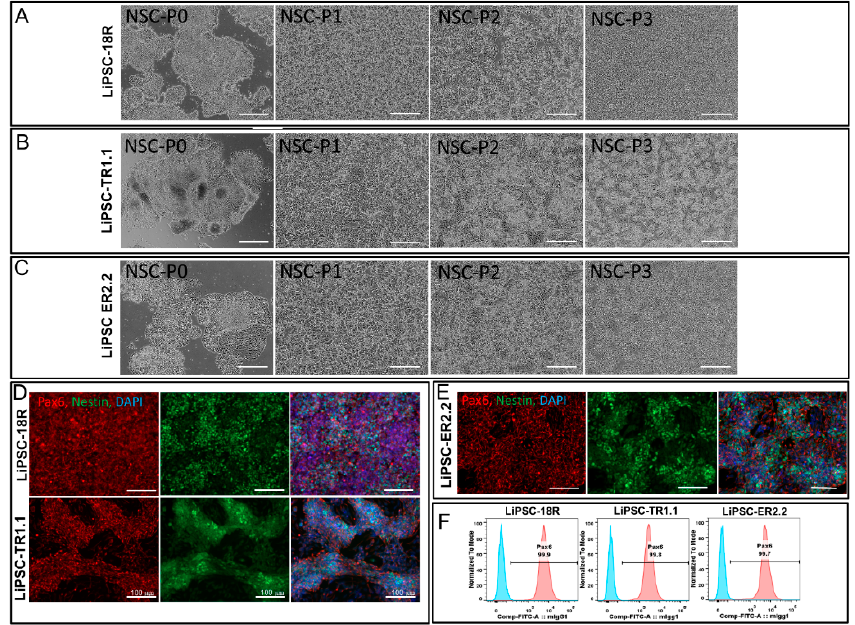
Figure 2. Neural di ff erentiation of LiPSC lines one passage post thaw. ( A – C ) Morphology of LiPSC lines was changing during the di ff erentiation from passage 0 (P0) to P3. ( D – E ) Immunofluorescent staining of neural stem cells (NSCs) at the end of P3 revealed that they express NSCs-specific markers (Nestin and Pax6). ( F ) Flow cytometry analysis at the end of P3 demonstrated high expression of Pax6 by cells acquired NSCs morphology. Scale bars, 100 µm.